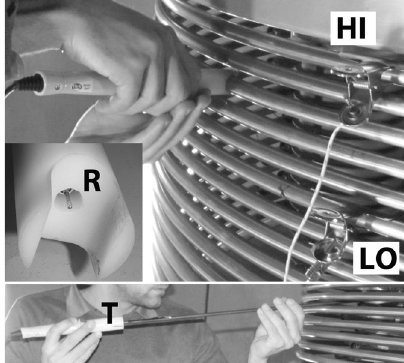
and R correspondingly where i is the gap number. The tubes TPi BPi and R correspondingly. The digits TTi BTi